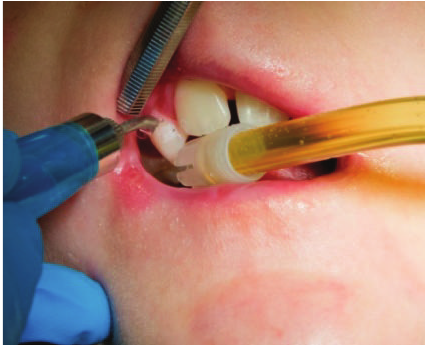
Figure 2: Treatment of hard dental tissues with Er:Yag laser.